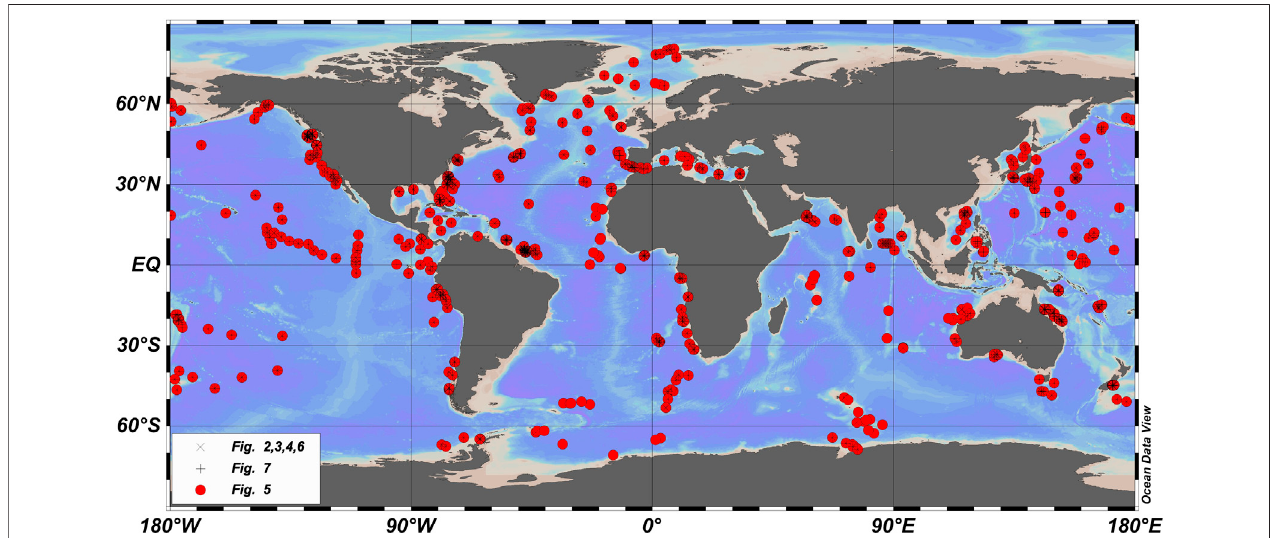
FIGURE 1 | Map of the global dataset from which data presented in this paper are presented.